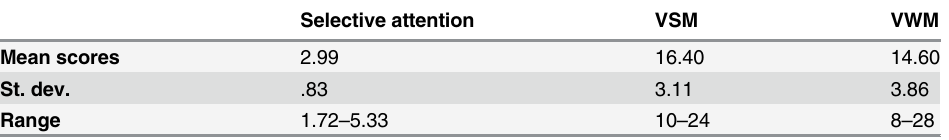
Table 10. Mean scores, standard deviations and ranges for children ’ s selective attention, visuospatial working memory and digit span backwards scores. Selective attention VSM